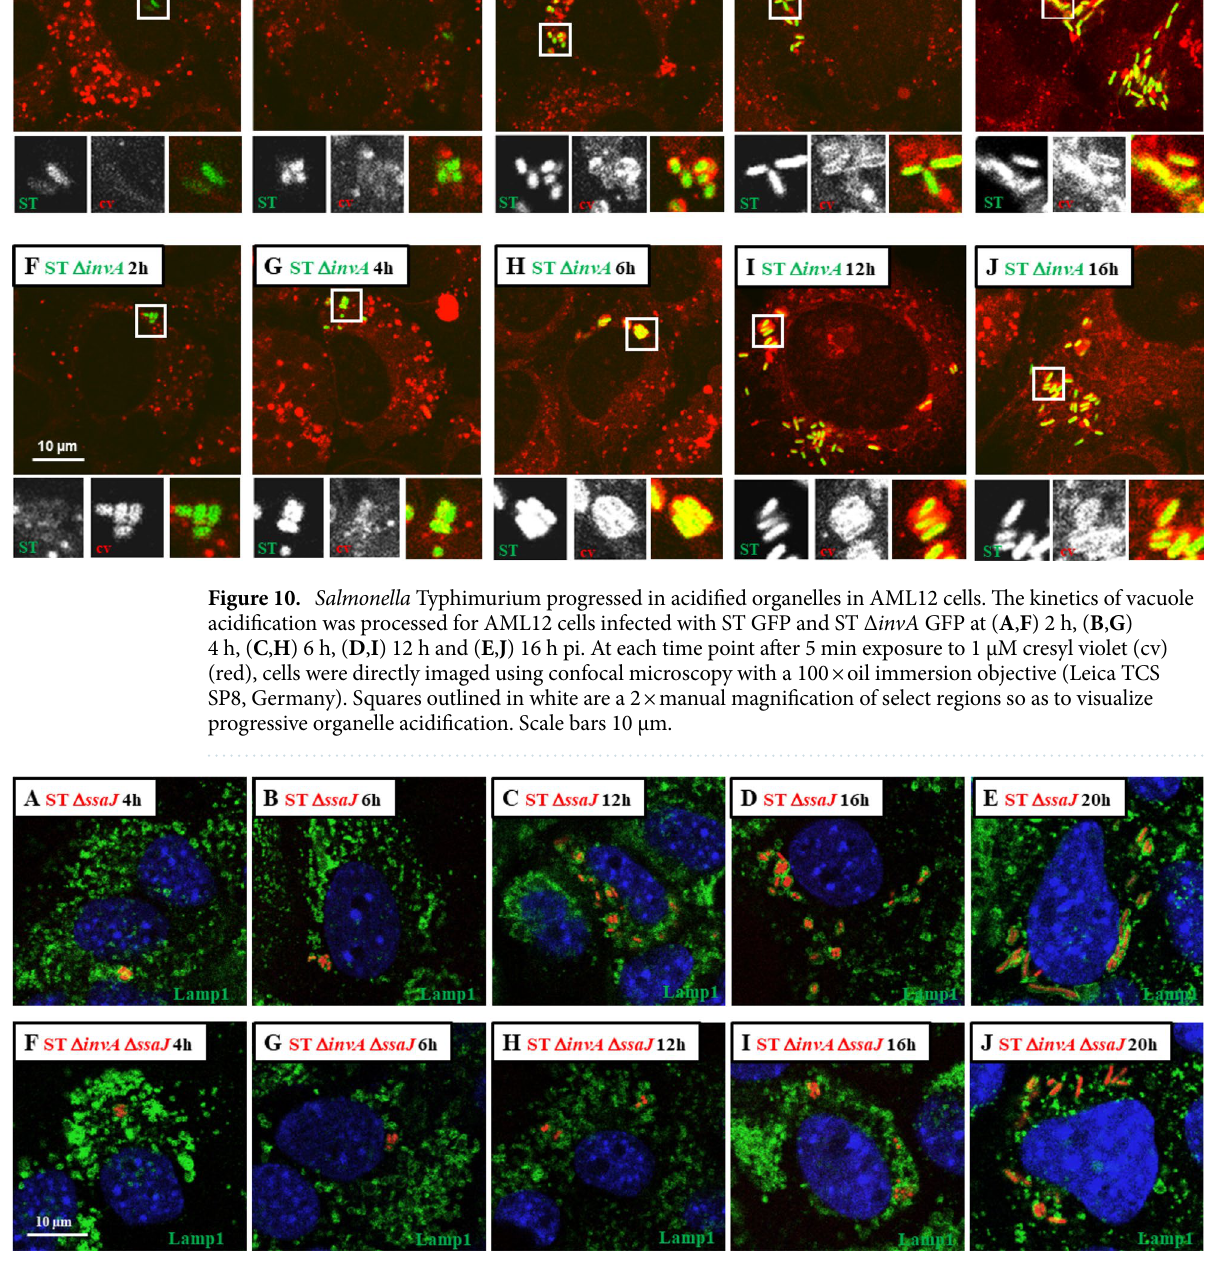
Figure 11. T3SS2-invalidated Salmonella Typhimurium resided in a vacuole in the presence of LAMP1 without SIF formation. The kinetics of LAMP1 recruitment was imaged for AML12 cells infected with ST Δ ssaJ DsRed and ST Δ invA Δ ssaJ DsRed at ( A , F ) 4 h, ( B , G ) 6 h, ( C , H ) 12 h, ( D , I )16 h and ( E , J ) 20 h pi. At each time point, cells were fixed and labelled with rat LAMP1 antibody, revealed with anti-rat Alexa Fluor 488 (green) and imaged using confocal microscopy with a 100 × oil immersion objective (Leica TCS SP8, Germany). Nuclei were counterstained with DAPI (blue). Scale bars 10